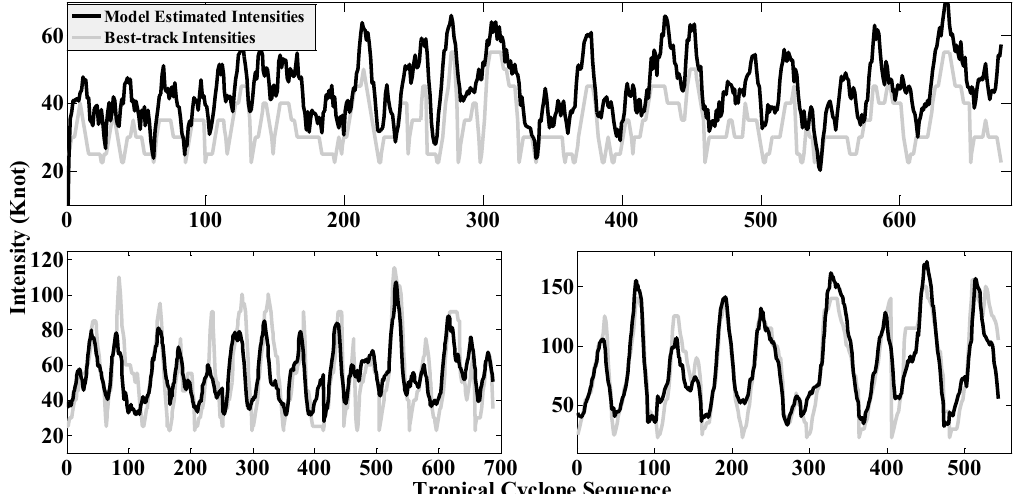
Figure 8. The sequences of the intensity of the 52 typhoons divided into three groups. The gray line indicates the best-track intensities and the black line represents the model estimated ones. 12-h smoothed (black solid line). The smoothed curve is consistent with the best-track curve ( R 2 of 0.91).